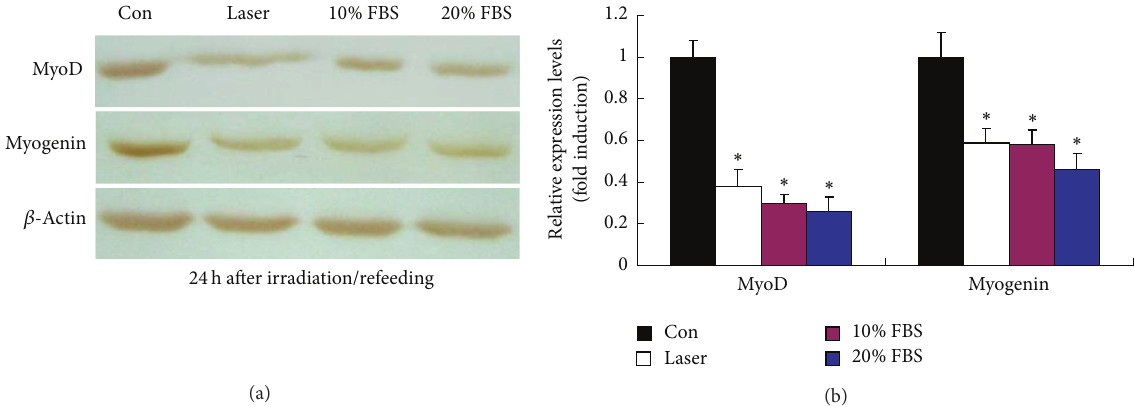
Figure 7: Effect of LPLI on MRFs expressions. Myoblasts were treated as above and harvested at the indicated time point followed by Western blotting. Blots were probed with antibodies against MyoD and myogenin, respectively (a). Relative expressions of MRFs were quantified by densitometric analysis and normalized to that of 𝛽 -actin. The data were presented relative to control group arbitrarily normalized to 1 (b). ∗ 𝑃 < 0.05 as compared with control group. Con stands for